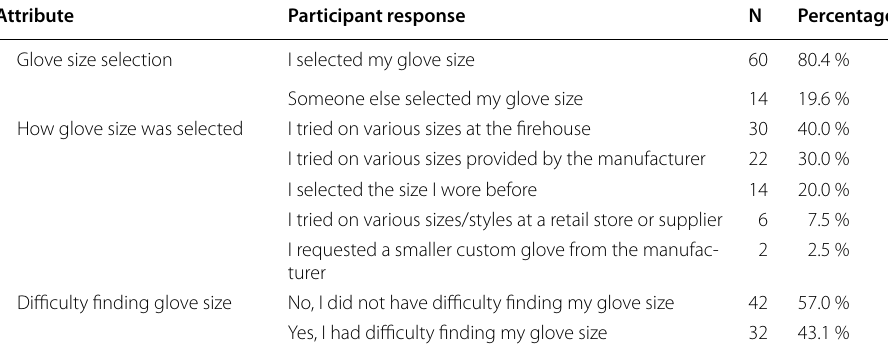
Table 7 1:1 Interview participant demographics